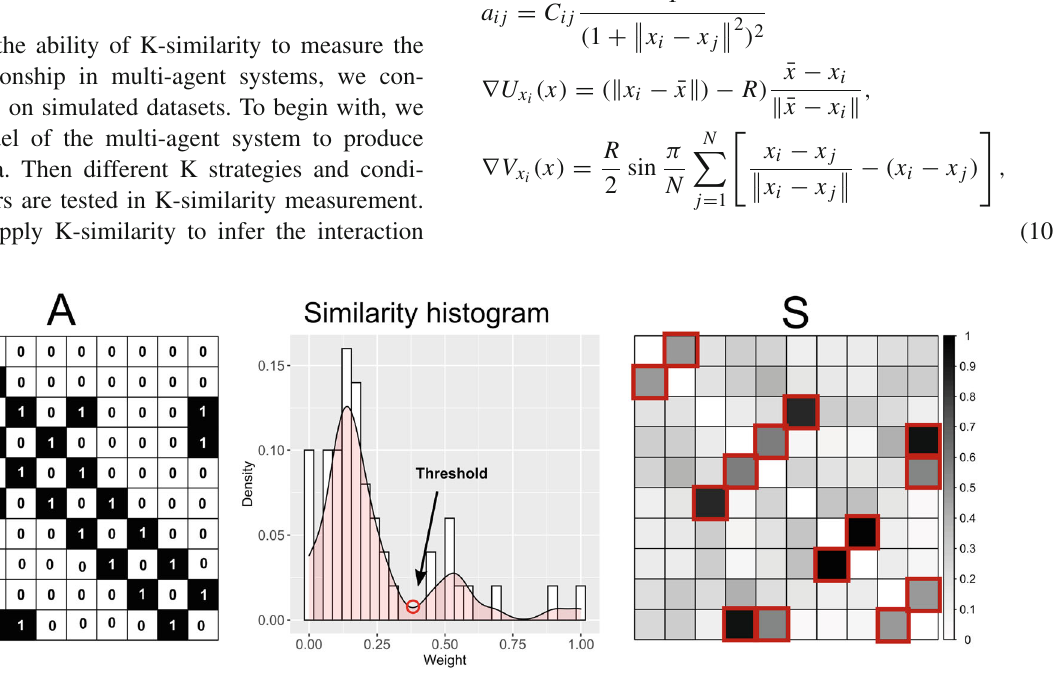
Fig. 2 Schematic diagram of GMM-based threshold